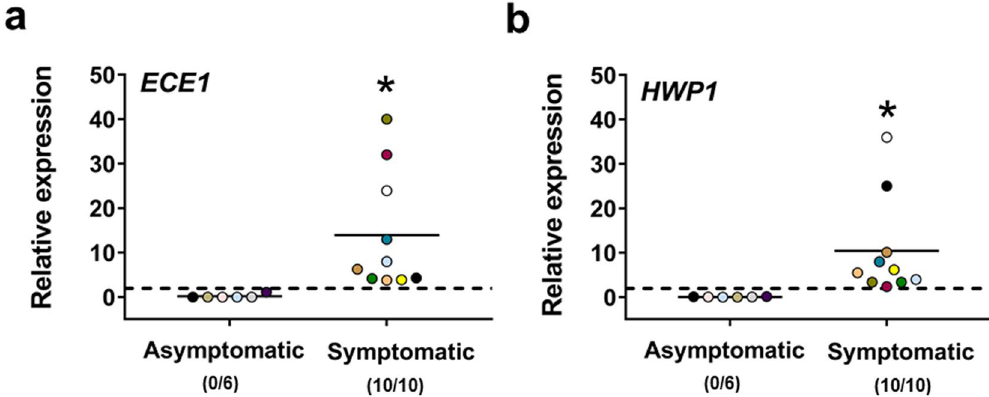
Figure 6. Quantitative analysis of ECE1 and HWP1 gene expression. Vaginal samples of asymptomatic (n = 6, identified by dots with different colors) and symptomatic (n = 10, identified by dots with different colors) women were centrifuged at 3000 rpm for 10 min, then cellular fractions were lysed and total RNA was extracted and retro-transcribed in cDNA. The expression levels of ECE1 ( a ) and HWP1 ( b ) genes in asymptomatic and symptomatic women were calculated by comparative Ct method (2 − ∆ Ct formula) after normalization with ACT1 gene. The results are from triplicates samples of each subject and the statistical significance was determined with Mann Whitney U test. The dashed line denotes the cutoff at which the overexpression of ECE1 and HWP1 genes was defined as > 2 times the value of ACT1 expression and the number of women expressing genes is indicated in the brackets. * p = 0.00012 symptomatic vs asymptomatic women for ECE1 and HWP1